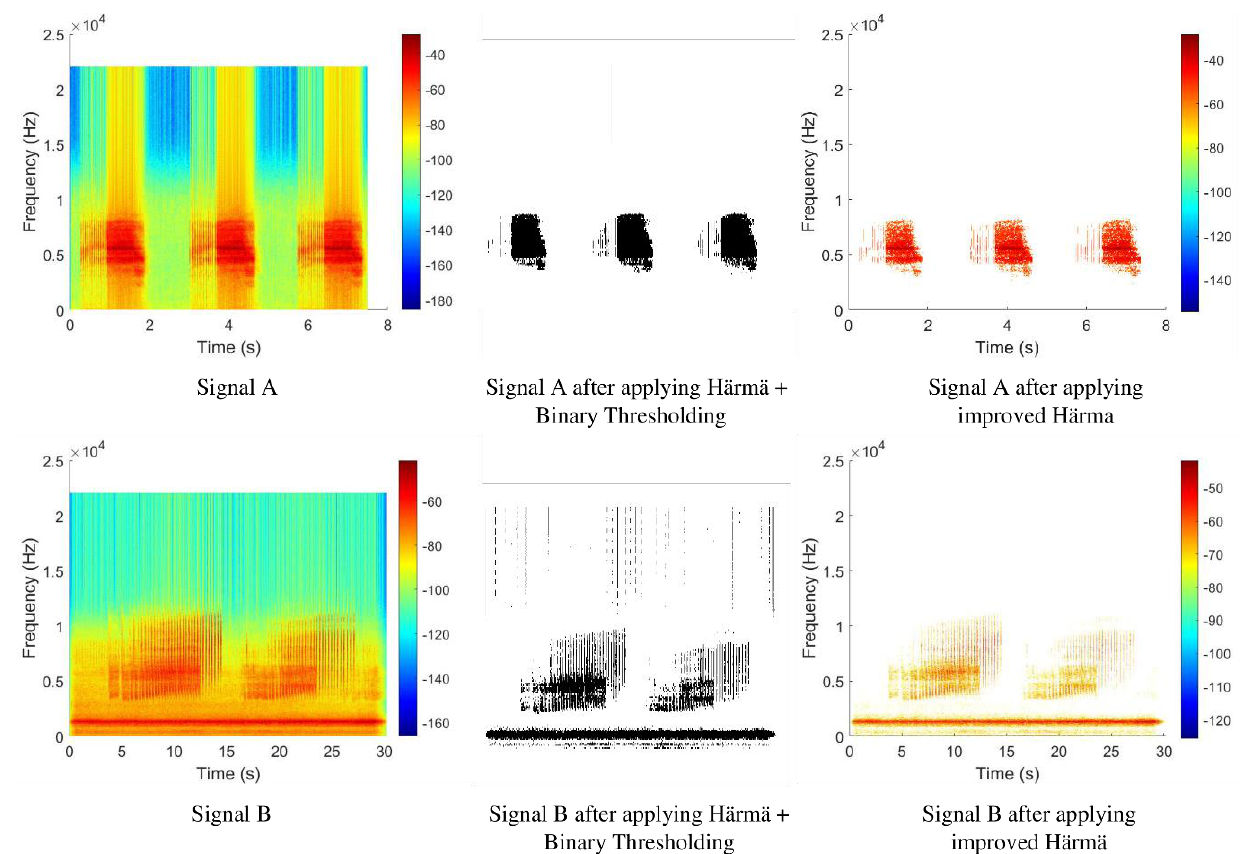
Figure 8. Spectrogram of signals before and after segmentation.